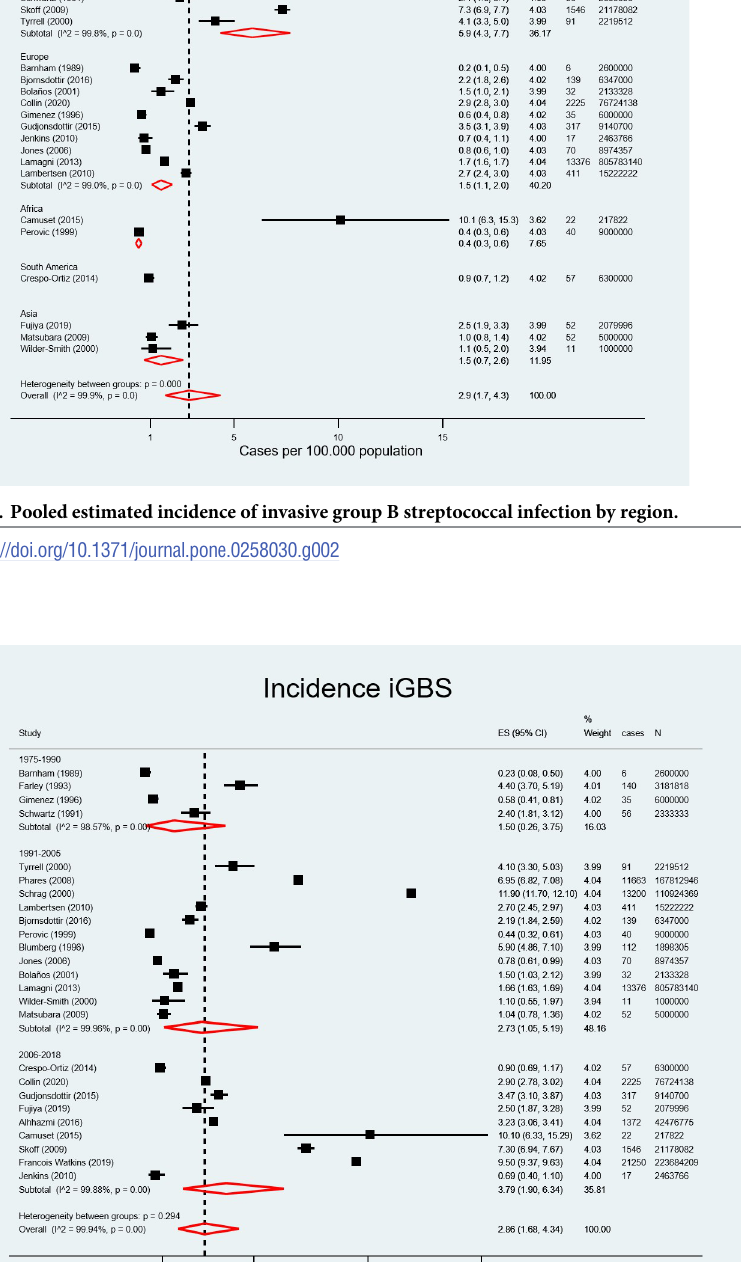
PLOS ONE | https://doi.org/10.1371/journal.pone.0258030 September 30,